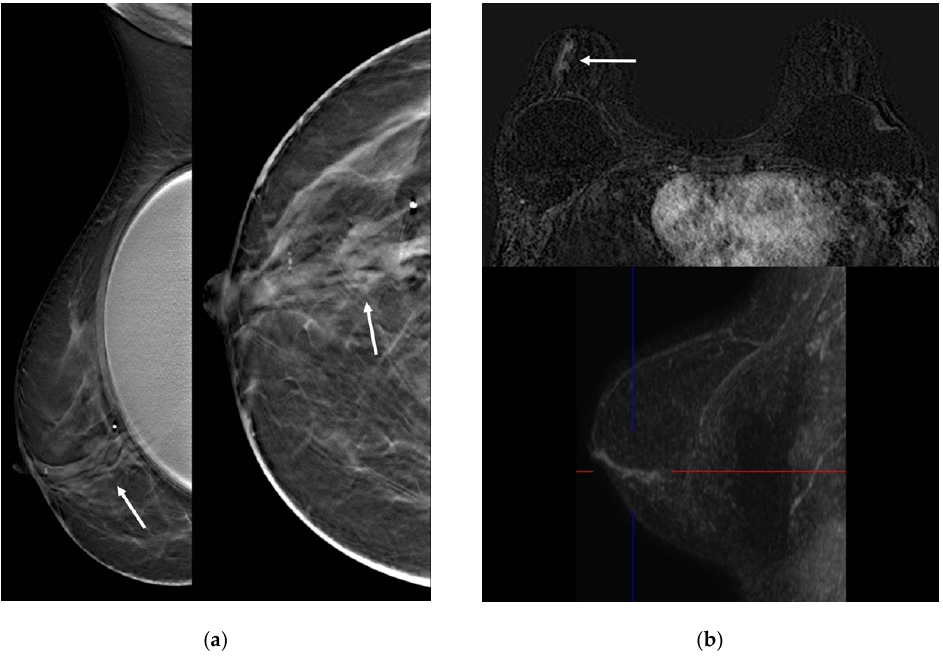
Figure 3. A 56-year-old woman with breast implants presenting with unilateral bloody nipple discharge. ( a ) Tomosynthesis slices in medio-lateral and cranio-caudal view with implant displaced showed multiple dilated ducts in the retroareolar region (arrows). ( b ) MRI showed ductal contrast enhancement (arrow).